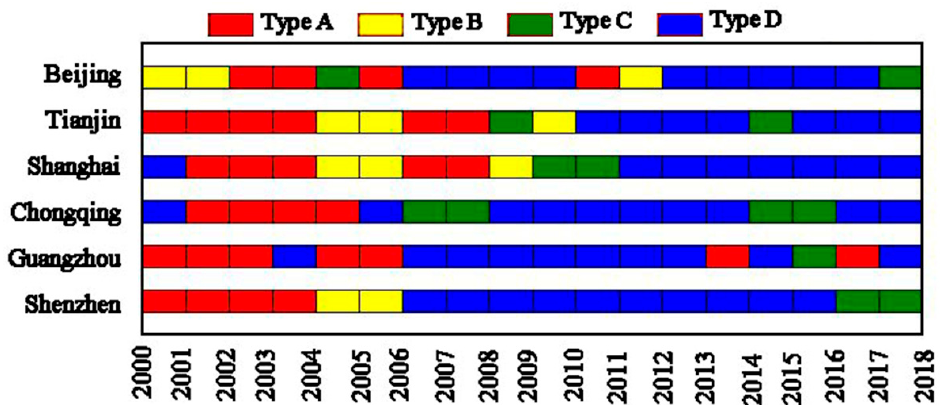
Figure 5. The expansion processes of urban lands in China’s megacities.